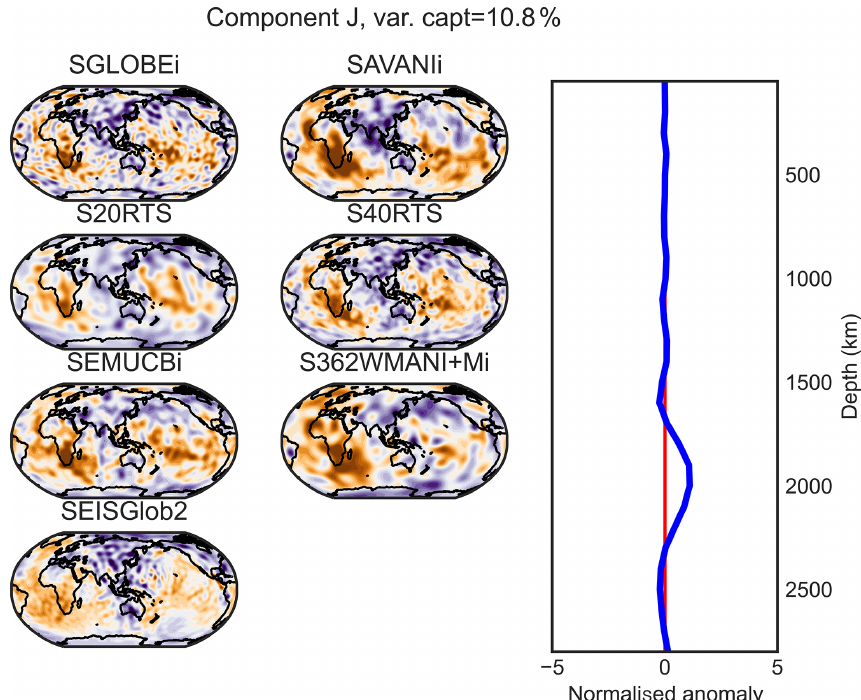
Figure D9. PC J (maximum at 2000km of depth) of the combined analysis of the isotropic parts of the models.